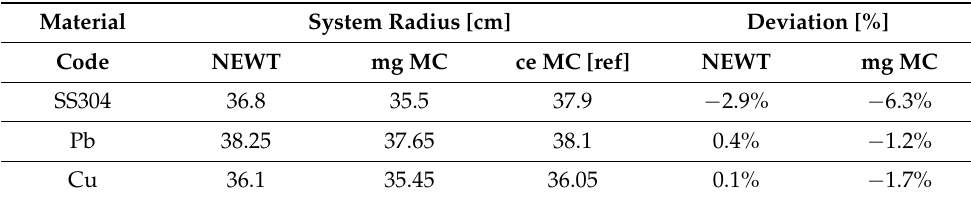
Table 1. Systematic comparison of the TRITON/NEWT multi-group results with KENO VI in the multi-group approach as well as the continuous energy